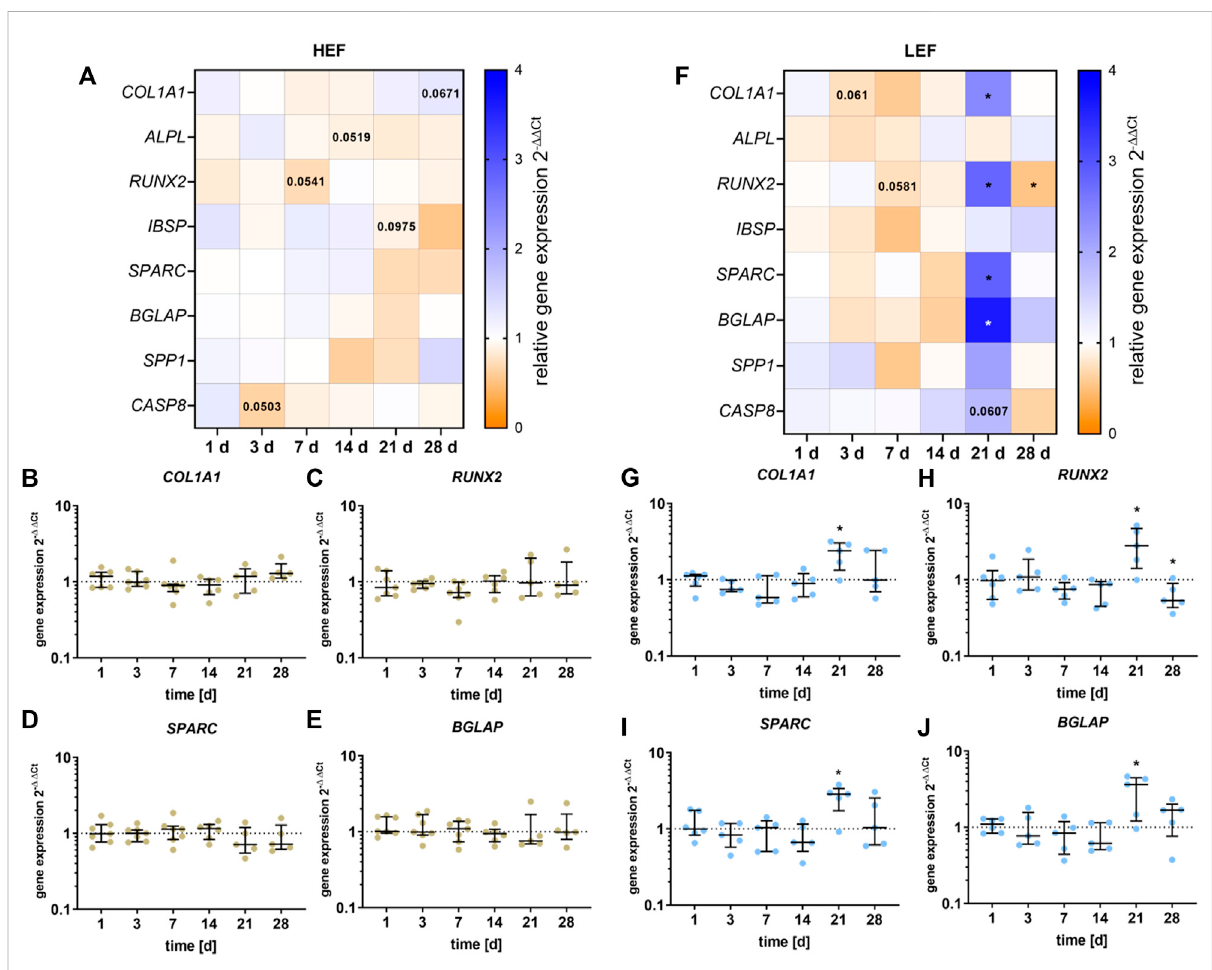
FIGURE 4 Gene expression analysis of osteogenic differentiation marker following stimulation with two different electric fi eld strengths [ (A – E) higher electric fi eld: HEF, (F – J) lower electric fi eld: LEF] related to the unstimulated control. Human pre-osteoblasts were stimulated over 28 days; the analysis time points were 1,3, 7, 14,21, and 28 days with assays performed 20 hafter the laststimulation interval started. Geneexpressionrates were acquired via qPCR and related to the control using the 2 - ΔΔ Ct method. (A,F) Results within heatmaps are shown as medians whereby the downregulation is identi fi ed in orange [ < 1], the upregulation in blue [ > 1], and a similar gene expression as the control in white [ = 1]. (B – E,G – J) The distribution of the total results [ n ≥ 5] are depicted as individual values with median and the 25%- and 75%-quartile. * p < 0.05: signi fi cant differences between the stimulated and control